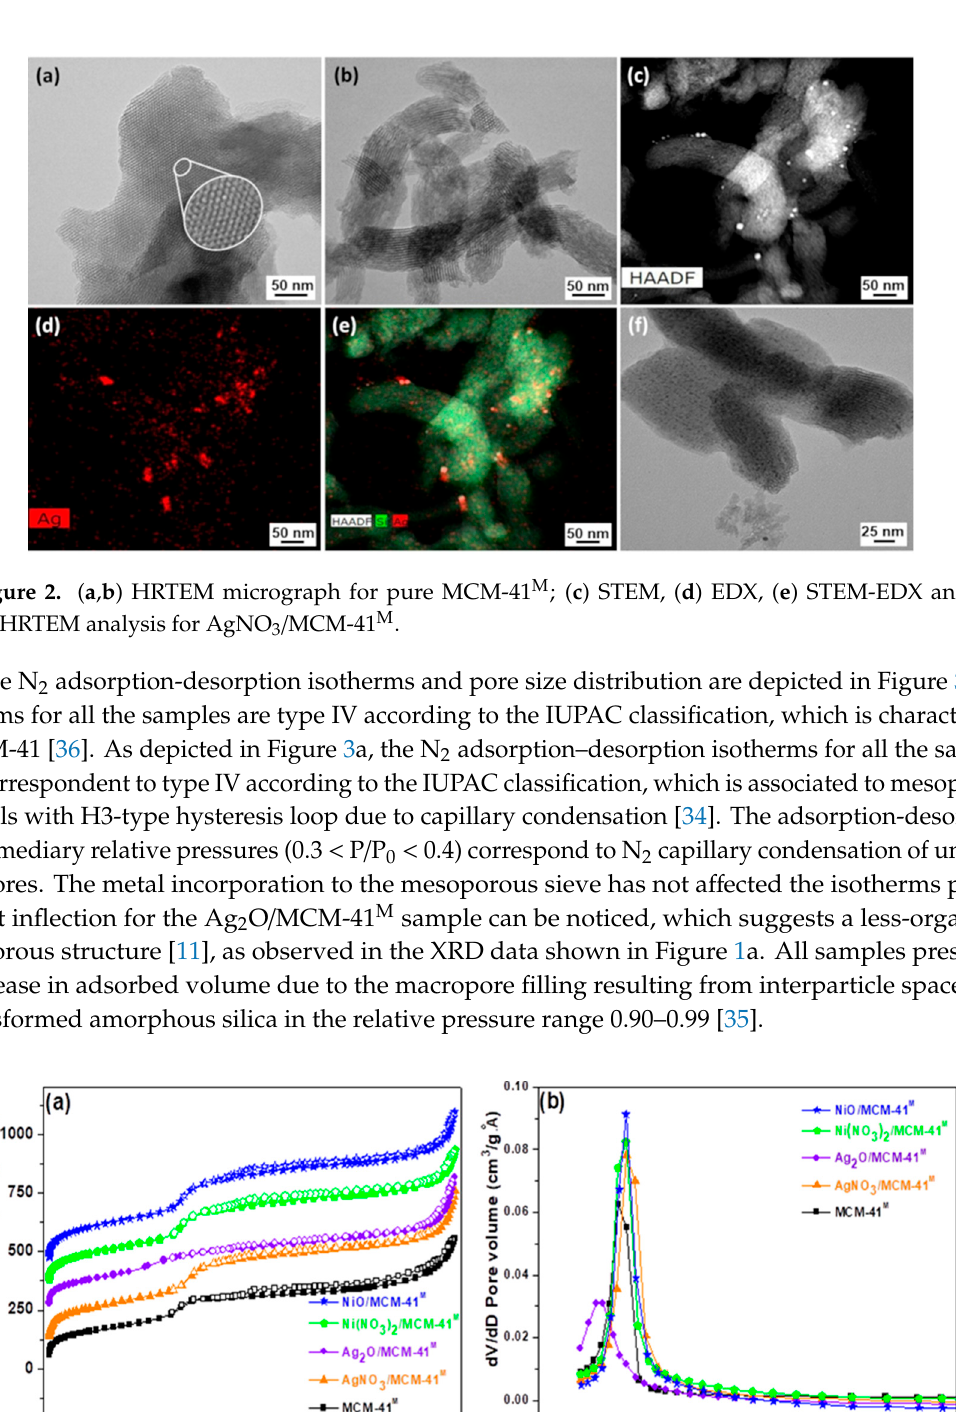
Figure 3. ( a ) N 2 adsorption-desorption isotherms at 77 K ( b ) and the corresponding BJH adsorption pore size distributions for the adsorbents.